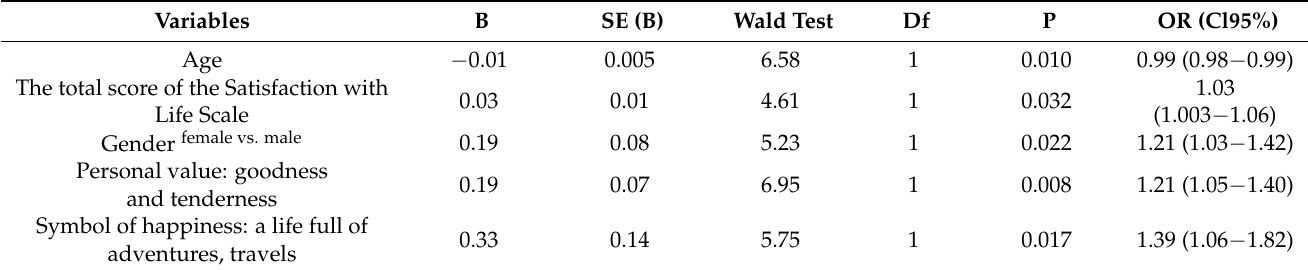
Table 3. Factors determining donation of a kidney to another human being (multivariate model of logistic regression).